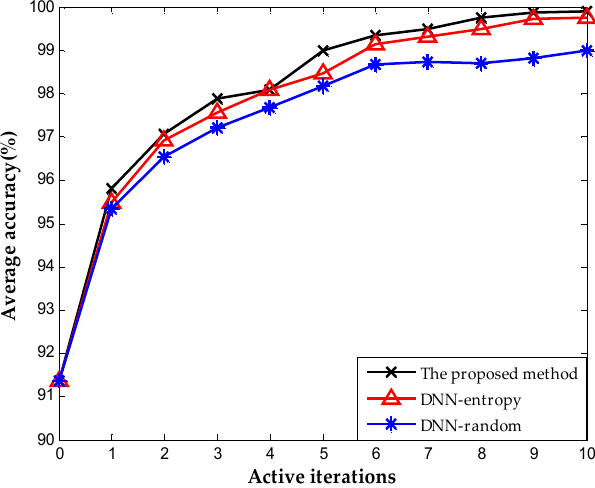
Figure 13. Classification accuracy obtained on TE dataset.